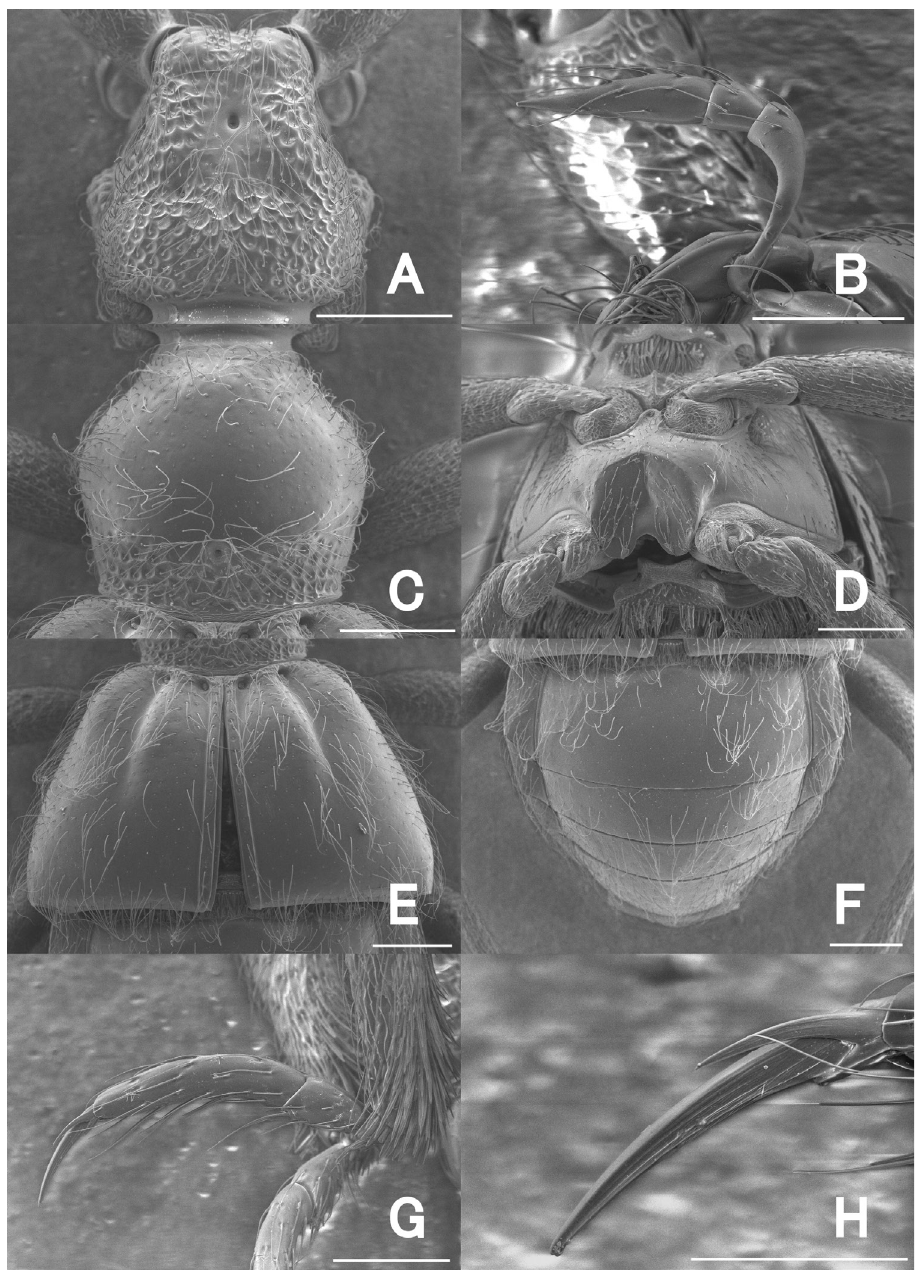
Figure 11. SEM images of Pseudophanias excavatus , male A head B maxillary palp C pronotum D metaventrite E elytra F abdomen G protarsus H protarsal claws. Scale bars: 0.2 mm ( A, C–F ); 0.1 mm ( B, G ); 0.05 mm ( H